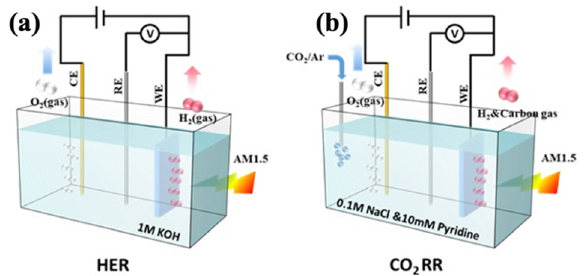
Figure 10. Three ‐ electrode configurations used for photoelectrochemical ( a ) hydrogen evolution reaction (HER) and ( b ) CO 2 reduction reaction (CO 2 RR) measurements. CE: counter electrode; RE: reference electrode; WE: work electrode.